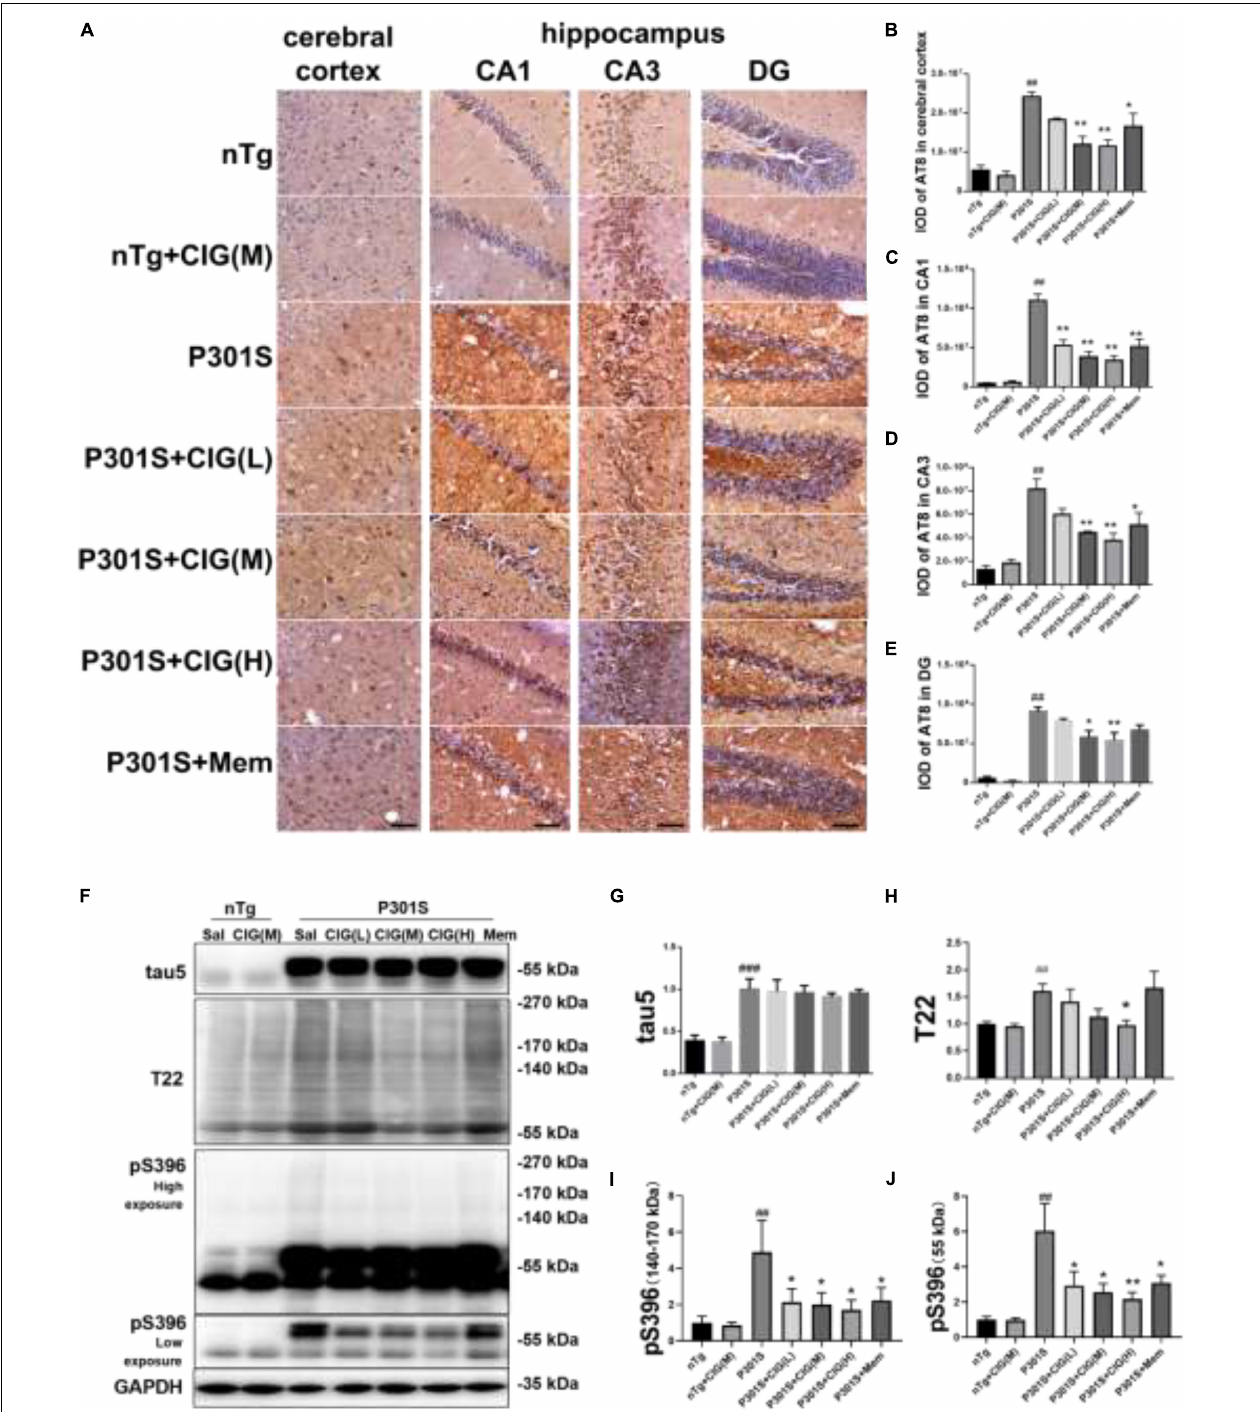
FIGURE 4 | Cornel iridoid glycoside (CIG) inhibited tau phosphorylation and accumulation in the brain of P301S transgenic mice. (A) Representative images of immunohistochemical staining of AT8 in the cerebral cortex, and hippocampus CA1, CA3, and DG areas of mice. Scale bar = 50 µ m. Quantitative analysis of integrated optical density (IOD) of AT8 in the cerebral cortex (B) and hippocampus CA1 (C) , CA3 (D) , and DG (E) areas of mice. (F) Representative images of Western blotting for tau5 (total tau), T22 (tau oligomers), monomer (low exposure), and oligomers (high exposure) of phosphorylated (p)-tau at Ser396 (pS396) in the brain of mice. Quantification of Western blotting for tau5 (G) , T22 (H) , pS396-tau oligomers [140 ∼ 170 kDa, (I) ], and monomer [ ∼ 55 kDa, (J) ]. Quantification of blots after normalization with GAPDH, and the numerical value of nTg group was taken as 1. Data are expressed as mean ± SEM; n = 3 per group for immunohistochemical staining; n = 4 per group for western blotting. ## P < 0.01, ### P < 0.001, P301S transgenic mice vs nTg control mice; * P < 0.05, ** P < 0.01, drug-treated P301S mice vs saline-treated P301S mice.